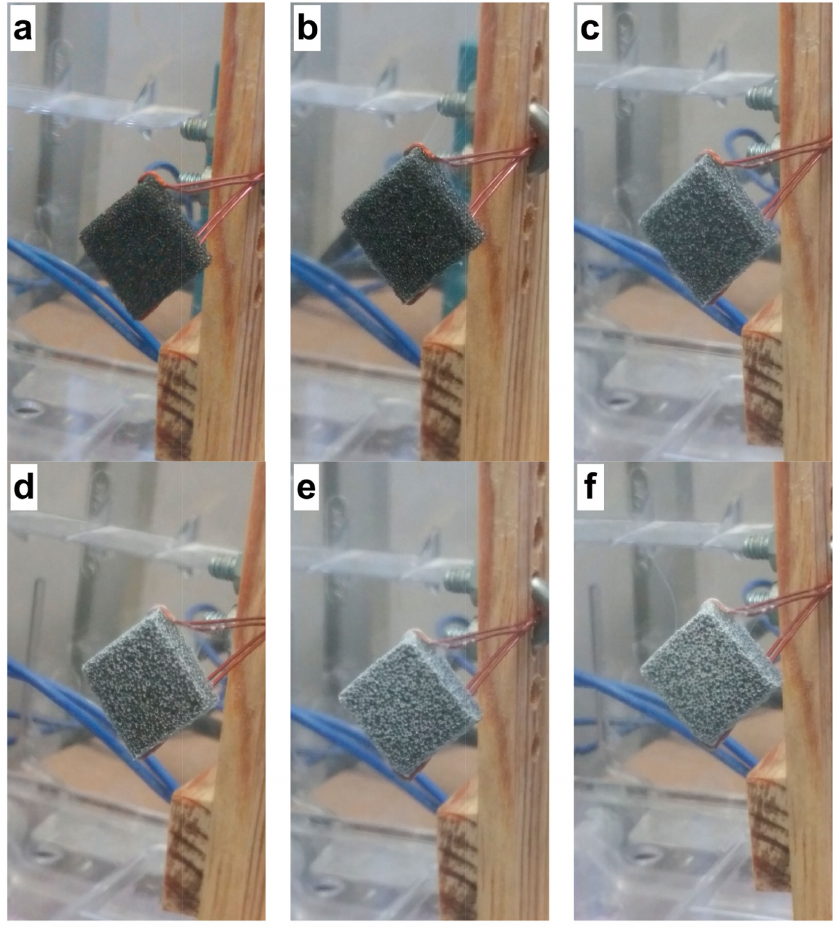
Figure 3. Electrospun fibers on the RVC support: ( a ) 0; ( b ) 15; ( c ) 30; ( d ) 60; ( e ) 90; and ( f ) 120